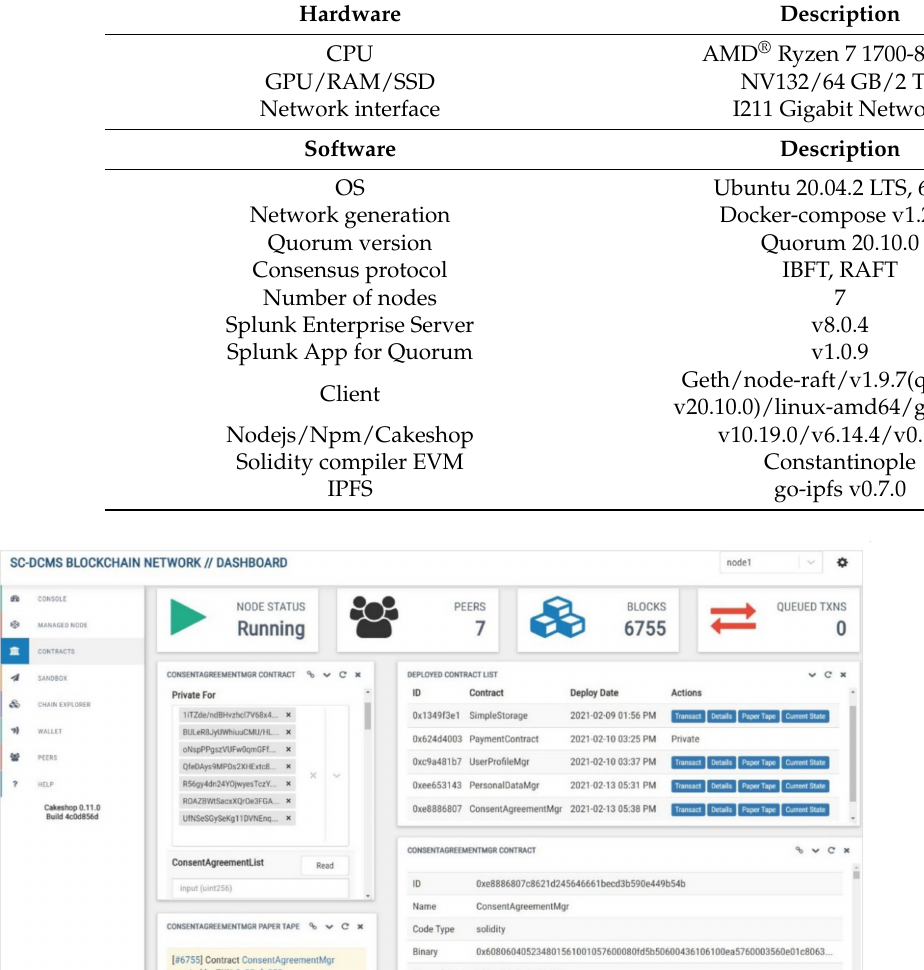
Table 4. Experiment environment setup.